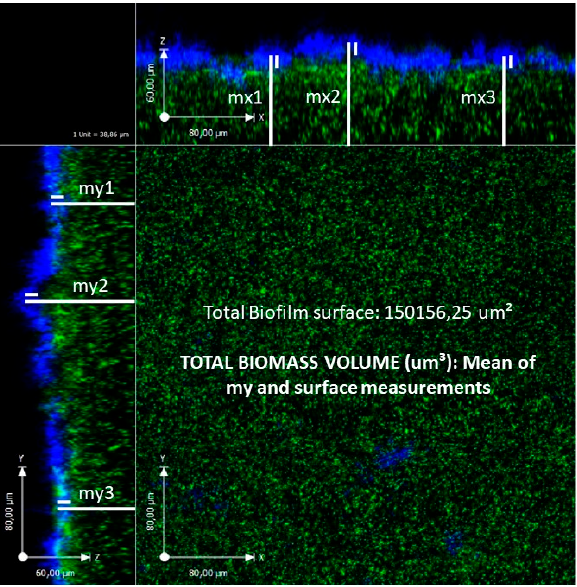
Figure 3. Total surface area of S. aureus biofilm after 48 hours (my = thickness measurement sides) as revealed by confocal laser scanning microscopy of an adenoidal specimen.